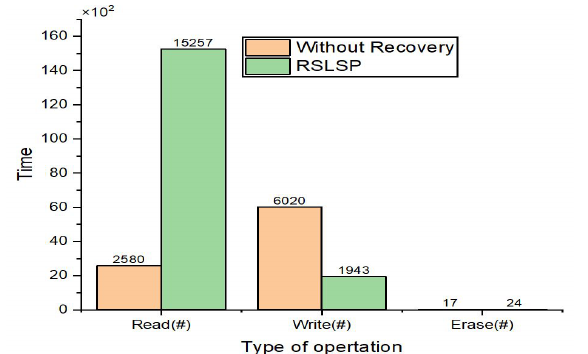
Figure 7. Performance results for pattern A.